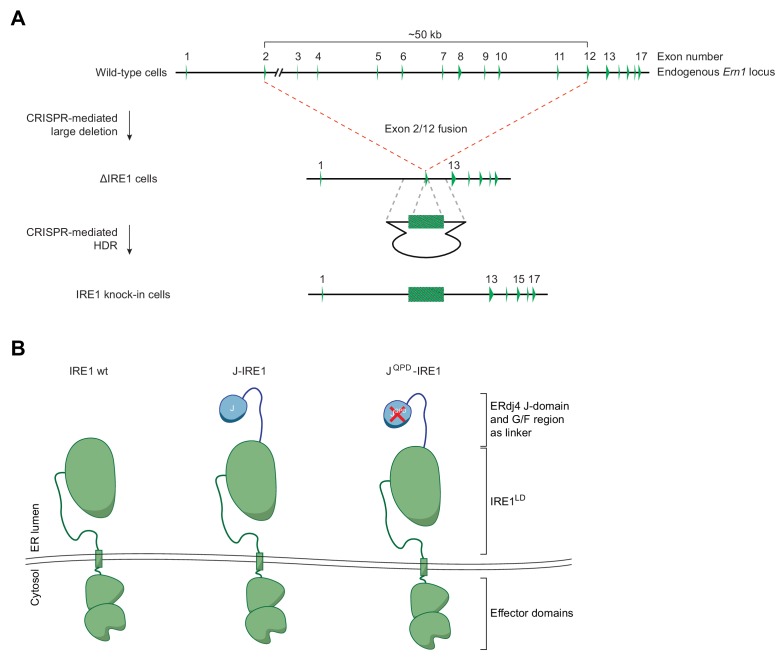
Modification of the endogenous Ern1 locus to introduce IRE1LD variants.(A) Schematic description of the homologous recombination platform for creating IRE1-encoding alleles at the endogenous Ern1 locus (ΔIRE1, Kono et al., 2017). Cas9-CRISPR guides generated a large in-frame deletion between exons 2 and 11 in the endogenous Ern1 locus. In the resultant Ern1 null cell line (ΔLD15) the locus can be targeted with a unique Cas9-CRISPR guide and appropriate repair templates containing an intron-free minigene consisting of exons 2–11 to generate IRE1LD variants stably expressed from the endogenous locus by homology-directed repair (HDR). (B) Scheme of IRE1 variants: wild-type IRE1 (wt) and chimeric J-domain IRE1 fusion proteins expressed from the endogenous Ern1 locus to probe the effect of BiP binding to IRE1 activity in cells. The J-domain (or QPD mutant) of ERdj4 was fused N-terminally to IRE1LD, whereby ERdj4’s glycine-phenylalanine-rich (G/F) region was included as a flexible linker between both domains.